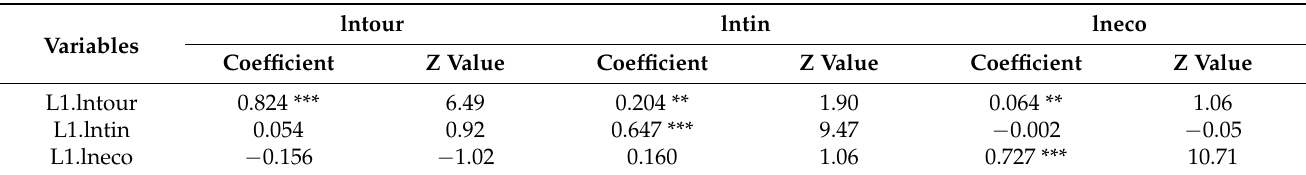
Table 8. GMM estimation